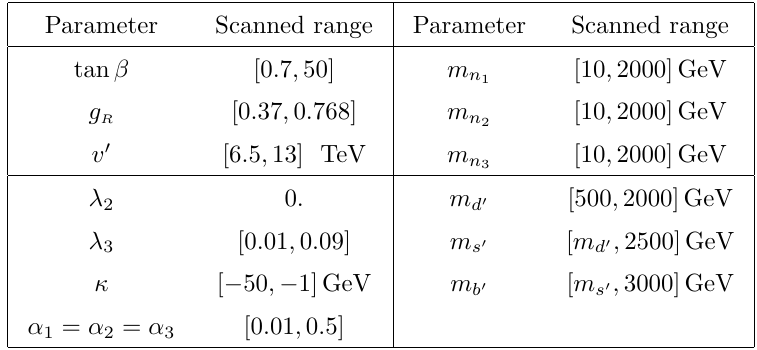
Table 2 . Ranges where the new parameters de(cid:12)ning the new physics sector of the model are allowed to